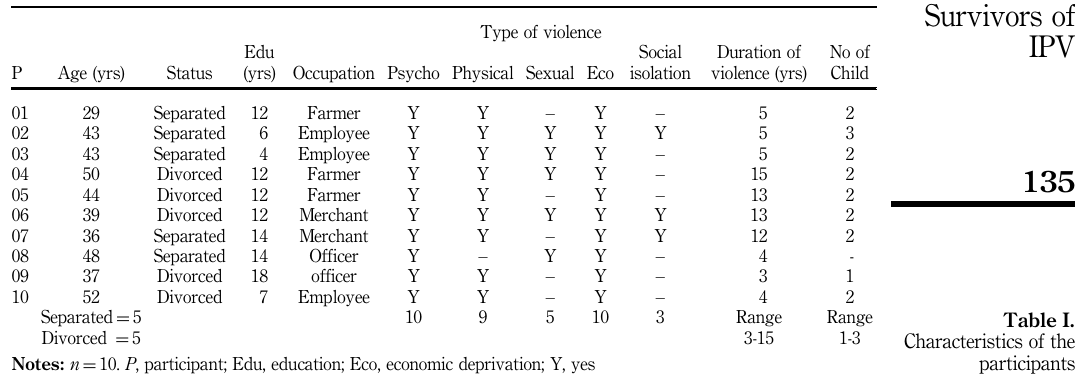
Table I. Characteristics of